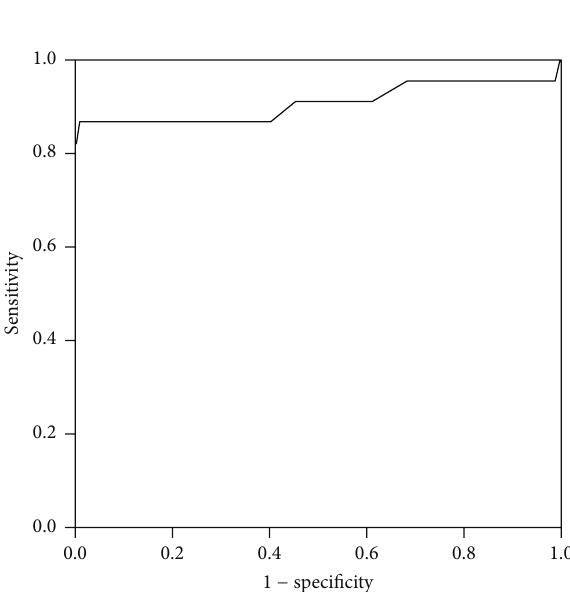
Figure 1: ROC curve for ABPI for having PAD among study pop- ulation. Diagonal segments are produced by